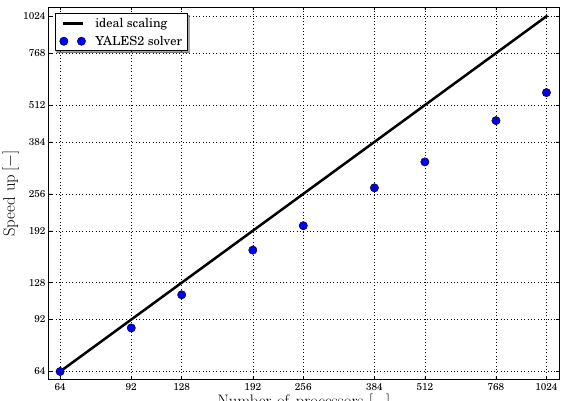
Figure 8. Speed-up curve obtained on the Birmingham fluidized